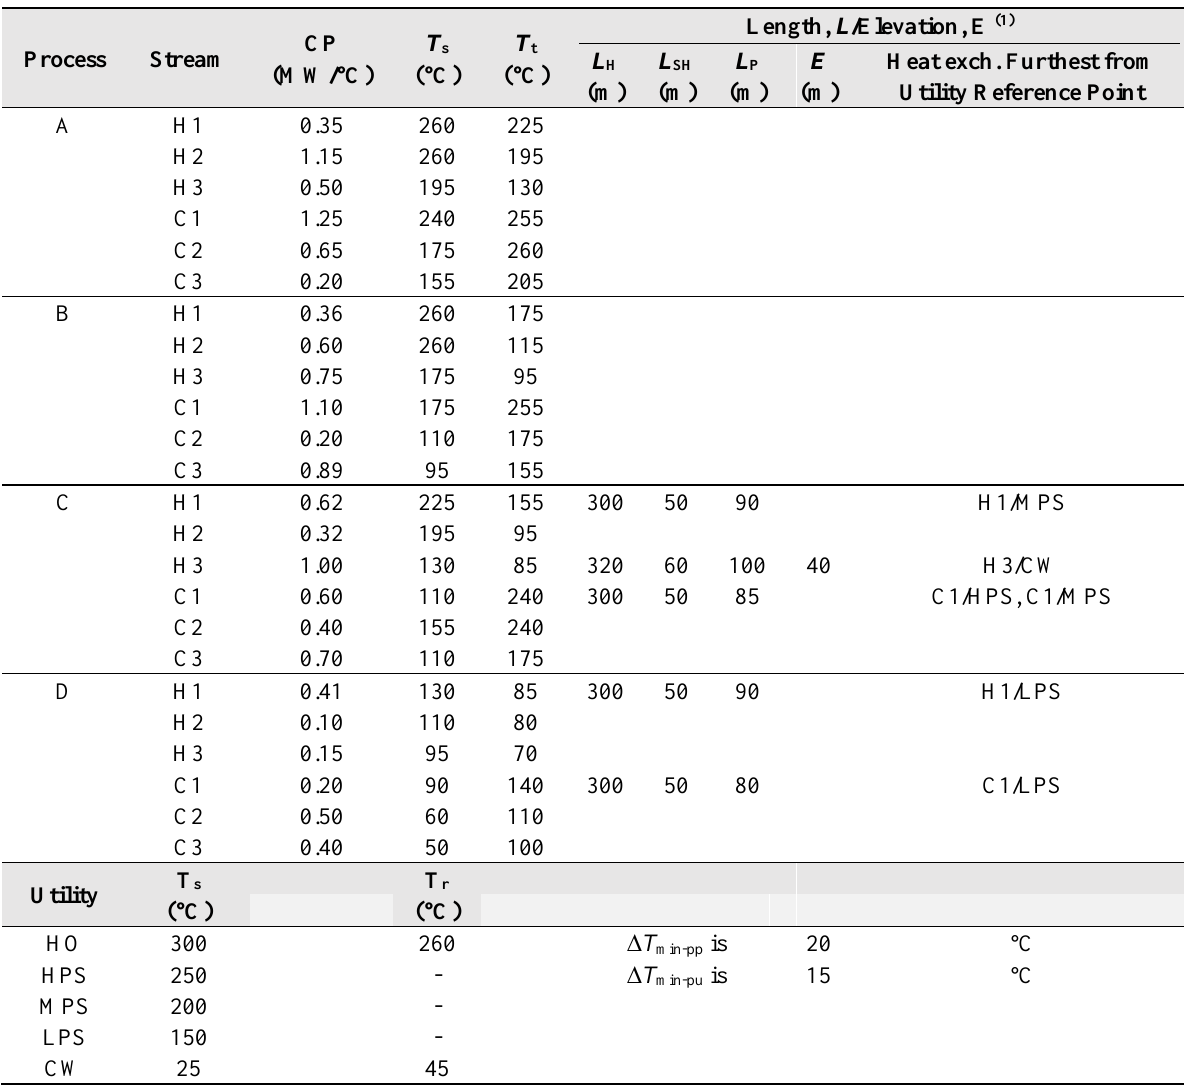
Table 2. Summary of input data for TS